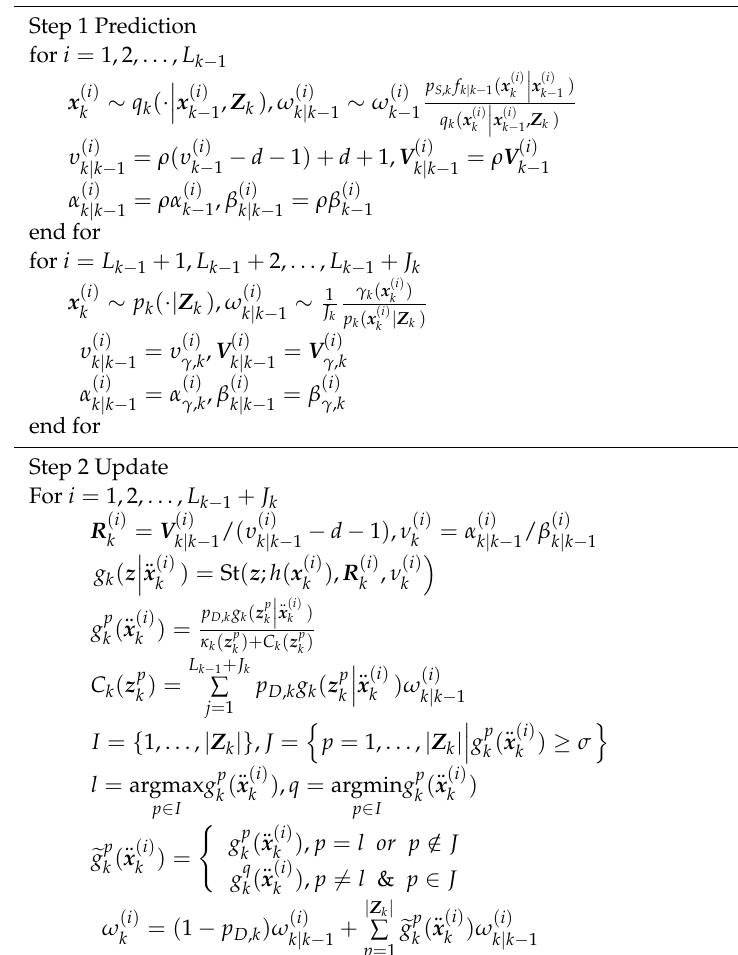
Algorithm 1. The robust SMC-PHD